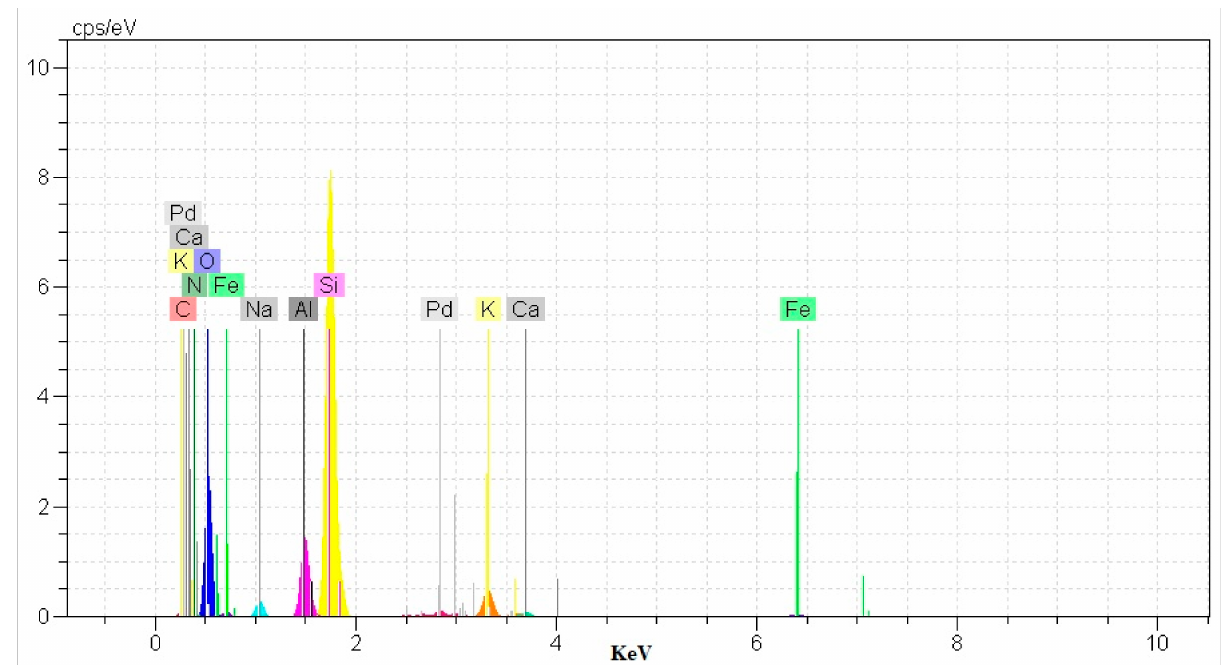
Figure 3. EDS analysis of the as-prepared